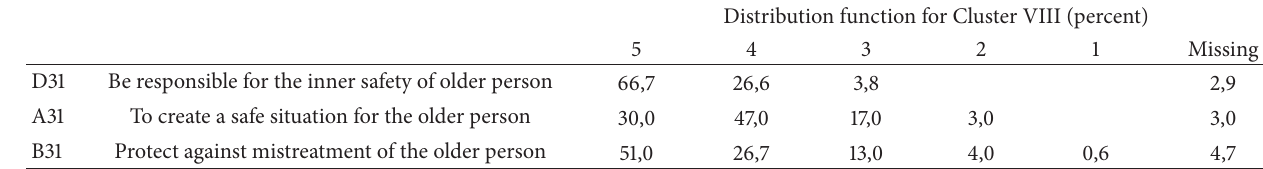
Table 16: Cluster VIII: possibilities for safety care.